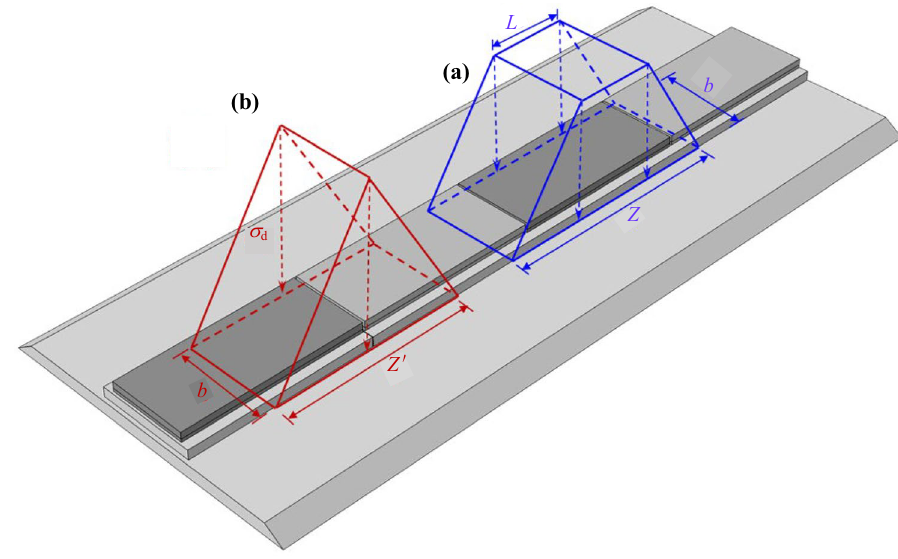
Fig. 13 Simplified distribution pattern of stress on roadbed: a loading at continuous structure; b loading at expansion